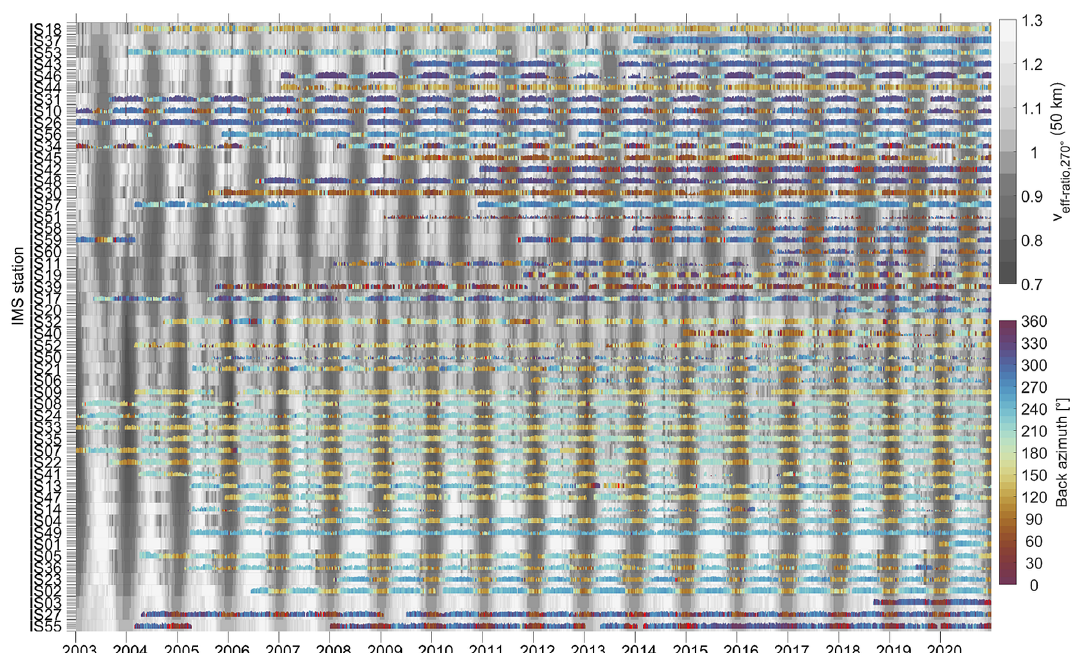
Figure C2. Similar to Fig. 11 but for the IMS infrasound detections in the microbarom frequency range (here 0.1–0.5Hz).